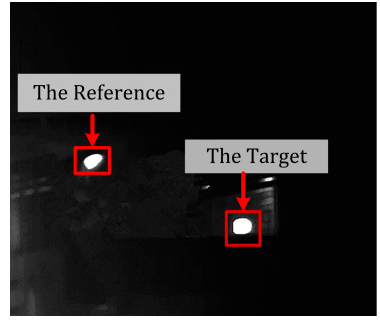
Figure 5. The site of IR radiometry.